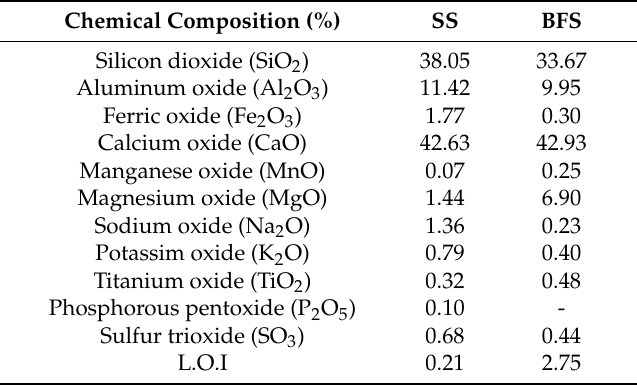
Table 5. Chemical composition of SS and